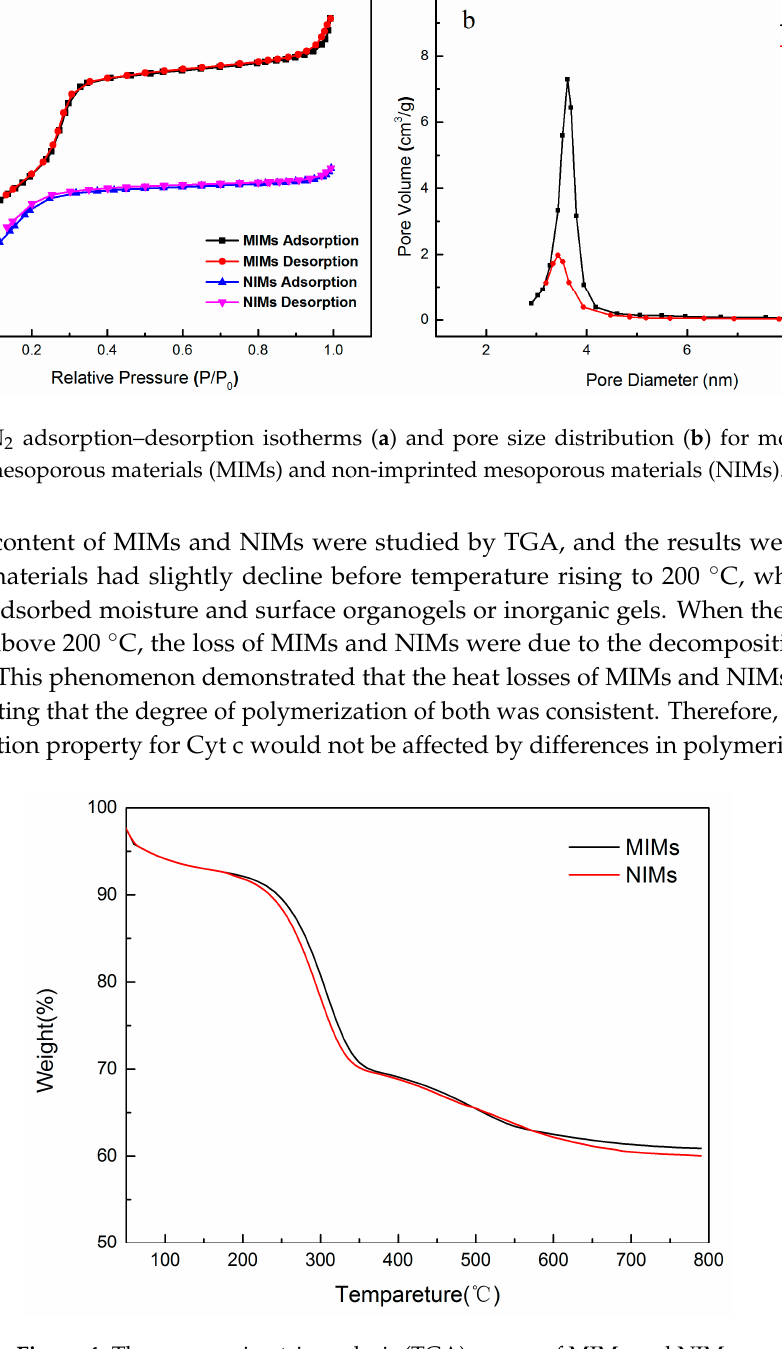
Figure 4. Thermo-gravimetric analysis (TGA) curves of MIMs and NIMs.